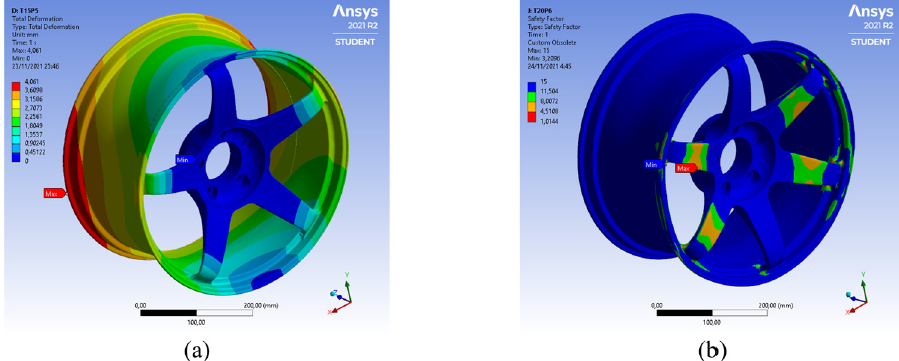
Figure 11: The highest value of displacement and safety factor: ( a ) MAP5T15 and ( b )